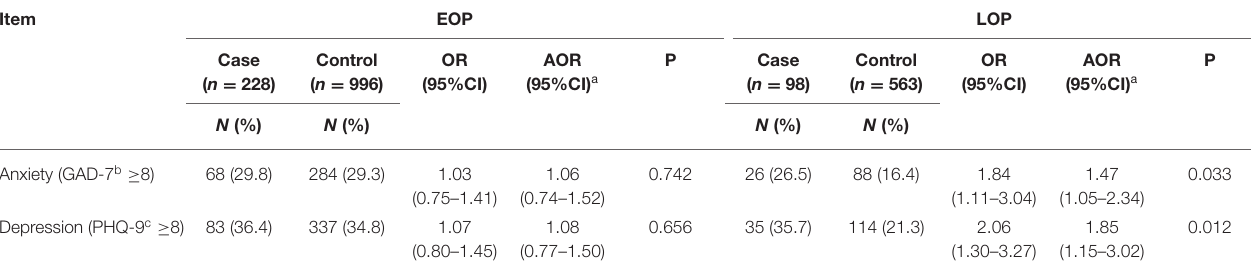
TABLE 3 | Subgroup analysis for the association between depression and anxiety the participants among two groups by Disease